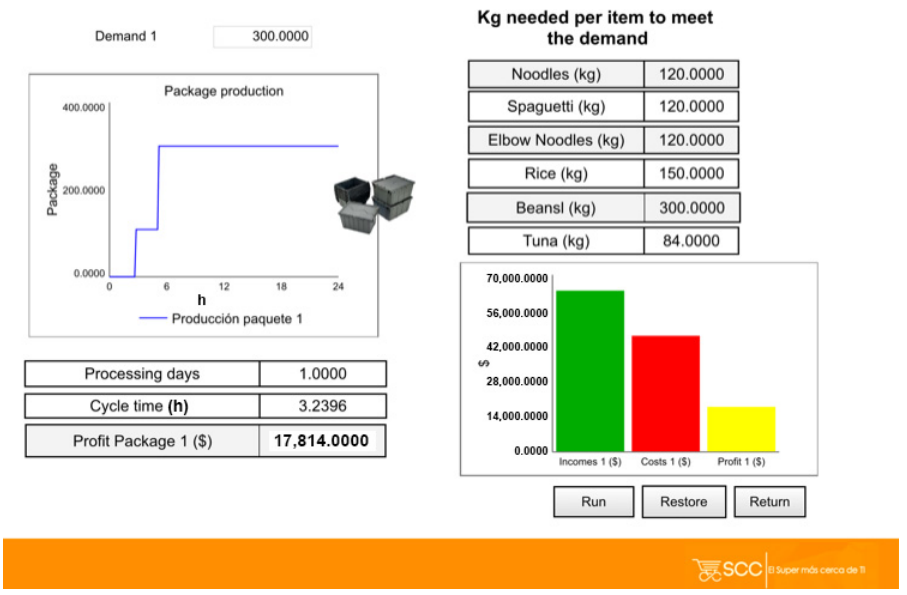
Figure 13. Optimistic interface behavior by package 1.